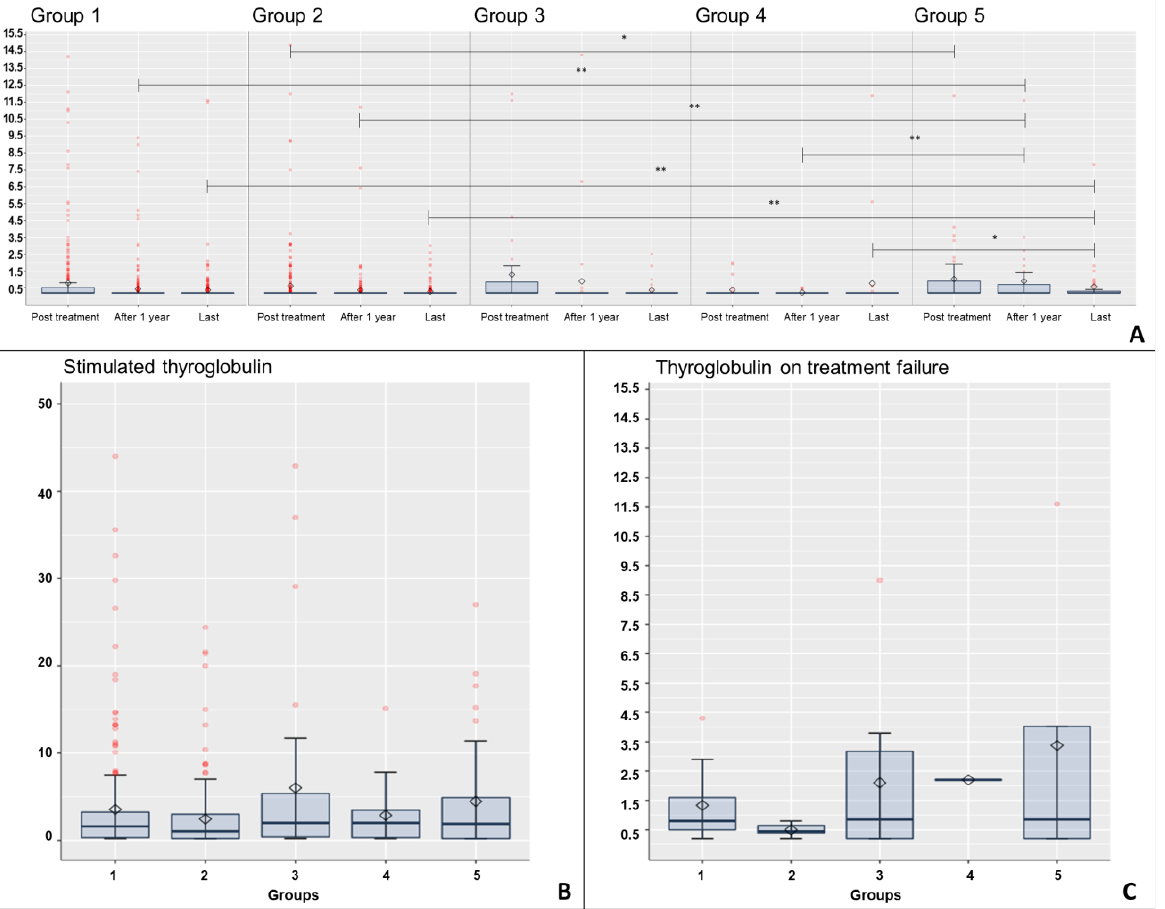
Figure 1. Boxplot charts demonstrating thyroglobulin levels (ng/mL) amongst groups. ( A ) Thy- roglobulin levels on three occasions during the follow-up in each group: immediately after treatment (surgery only or after radioiodine therapy), one year after initial treatment and in the last medical appointment demonstrating significantly different levels between groups as indicated by comparative lines. ( B ) Stimulated thyroglobulin levels during the first whole-body scintigraphy examination presenting similar levels ( p = 0.087 — Kruskal – Wallis test). ( C ) Thyroglobulin levels assessed immediately before treatment failure identification presenting similar levels ( p = 0.610 — Kruskal – Wallis test). Note: Group 1: Total thyroidectomy without incidental lymph node resection; Group 2: Total thyroidectomy with incidental lymph node resection without lymph node metasta- sis; Group 3: Total thyroidectomy with incidental lymph node resection and lymph node metastasis; Group 4: Total thyroidectomy with central compartment neck dissection without lymph node me- tastasis; Group 5: Total thyroidectomy with therapeutic central compartment neck dissection (with lymph node metastasis); * p < 0.05 and ** p < 0.01 (Kruskal – Wallis test —Dunn’s test amongst groups).